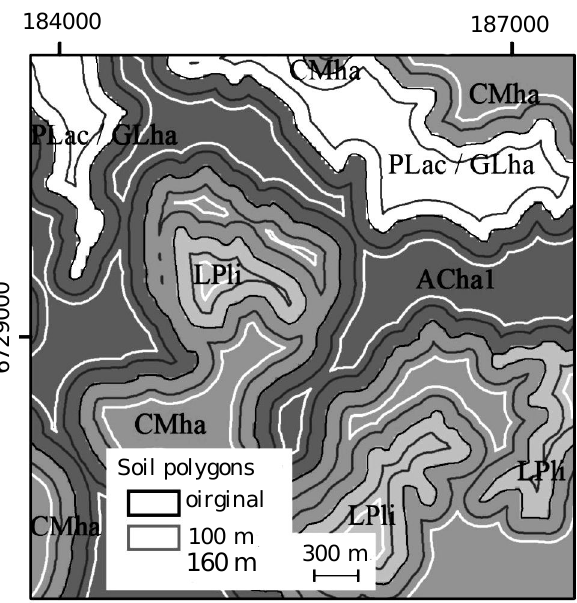
Figure 1. Sampling strategies of the predictive covariates adopted in the study using the original soil map, with a displacement of 100 and 160 m from the edge of the polygons. Acric Planosol (Albic, Epiarenic)/Haplic Gleysol (Dystric, Siltic) [PLac/GLha], Haplic Cambisol (Dystric, Chromic)[CMha], Lithic Leptosol (Humic, Eutric) [LPli] and Haplic Acrisol (Profondic, Chromic) [ACha1]. Coordinate system SIRGAS2000/UTM zone